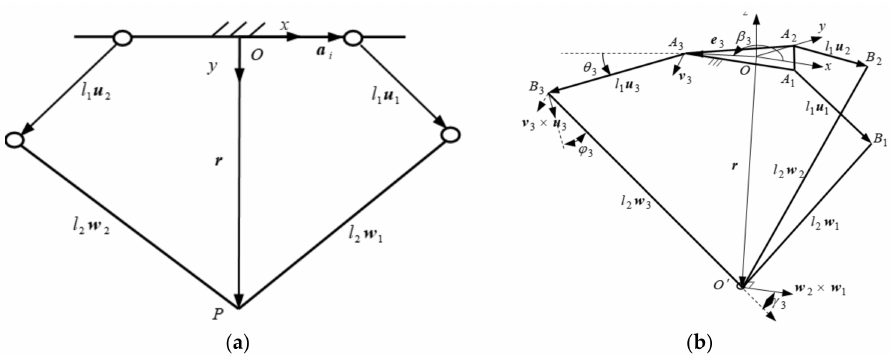
Figure 4. Schematic diagram of the Diamond robot and Delta robot. ( a ) Diamond robot; ( b ) Delta